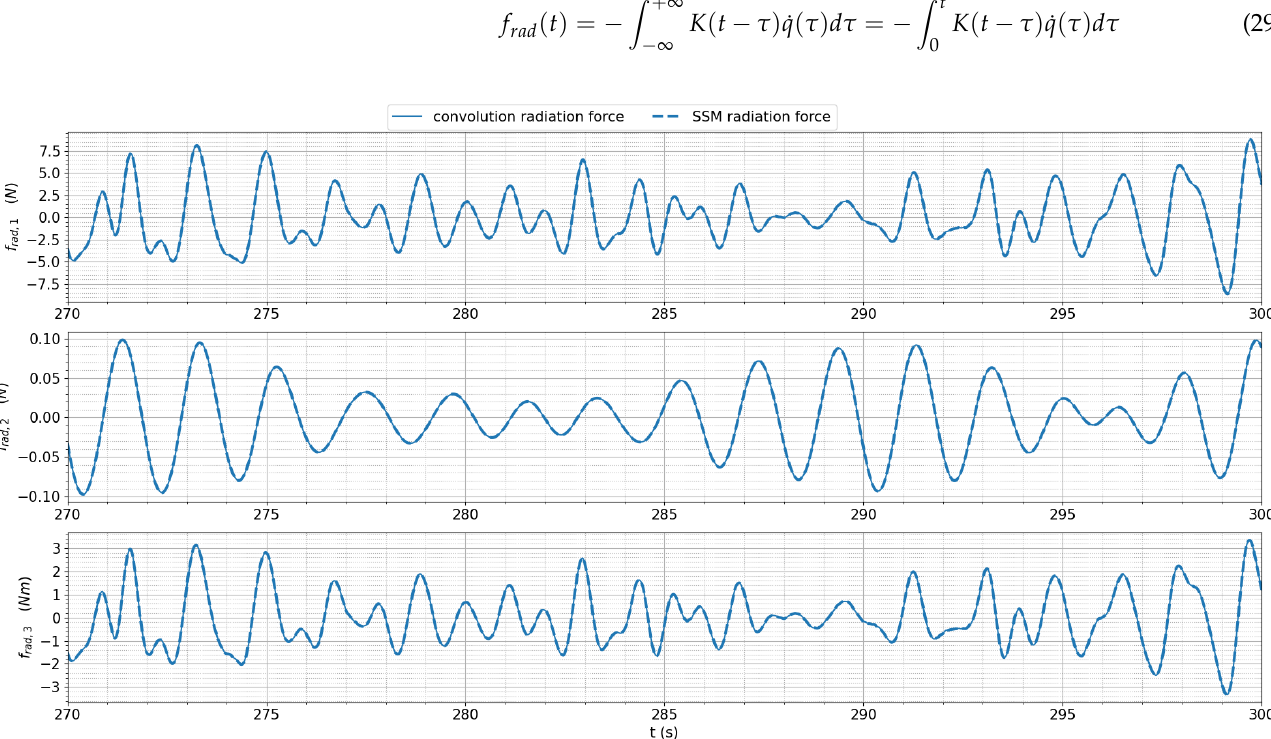
Figure 11. Comparison between convolution and